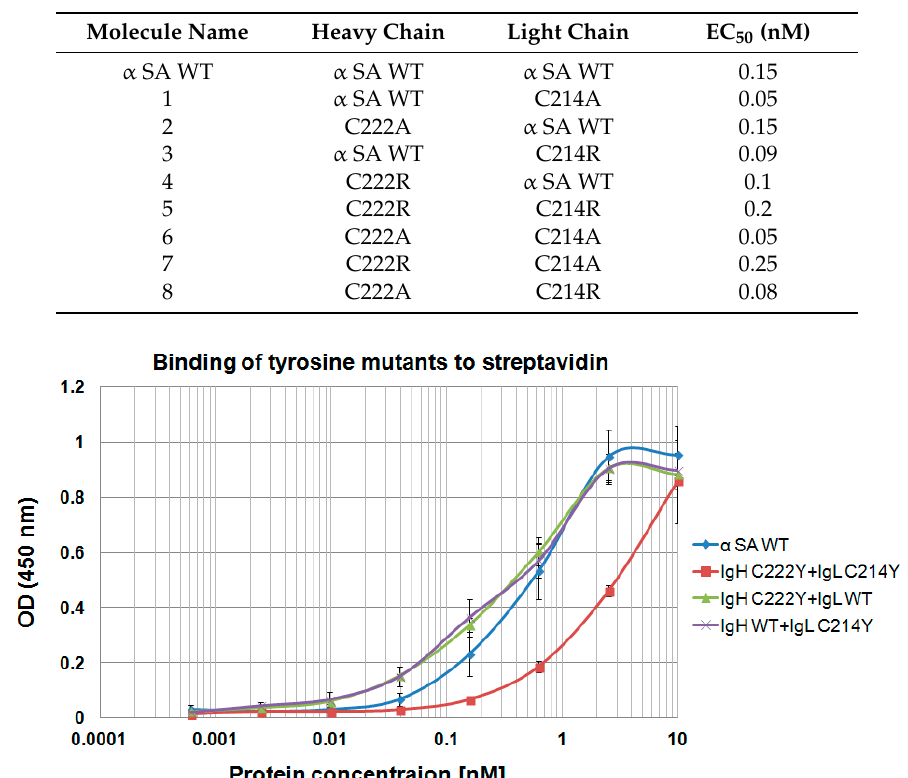
Table 2. Summary of the EC 50 values of “Arginine mutants” family as were extracted from ELISA binding curves to streptavidin.